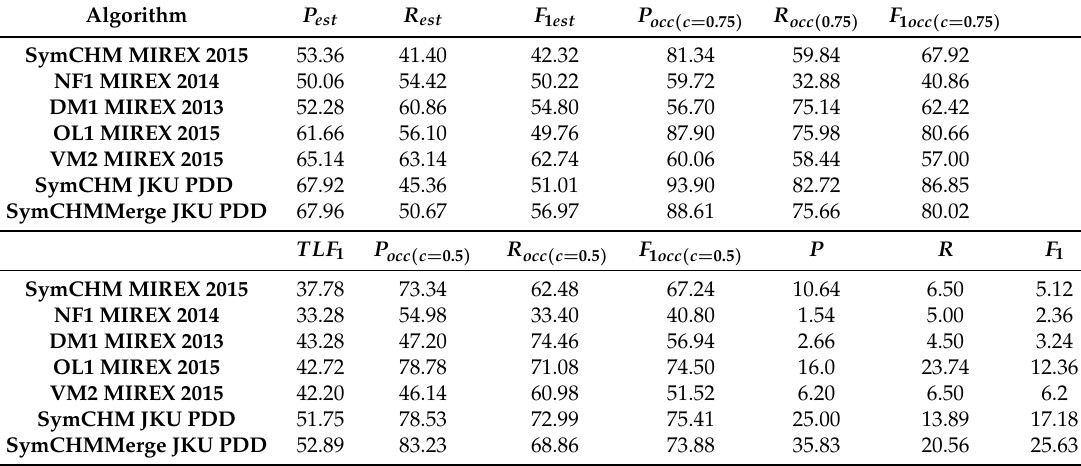
Table 2. Evaluation of SymCHM, SymCHMMerge and Music Information Retrieval Evaluation eXchange (MIREX) results of other proposed approaches for the discovery of repeated themes and sections task on the JKU Patterns Development Dataset (PDD) and JKU Patterns Testing Dataset (PTD), denoted as MIREX